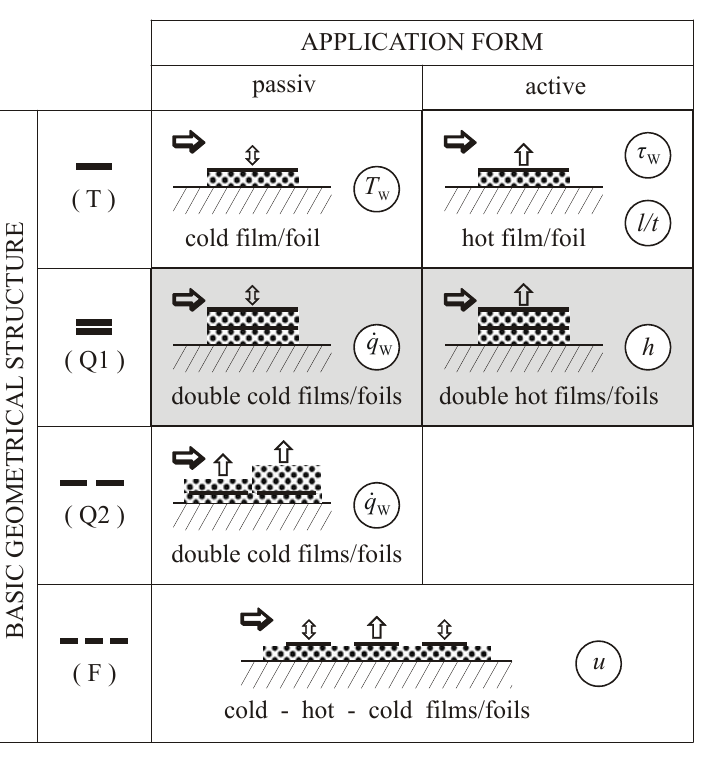
Figure 1. Characterization scheme for RTS film- and foil-sensors. : metal film/foil; : solation,thermal barrier (e.g., polyimide foil); : flow direction; : heat